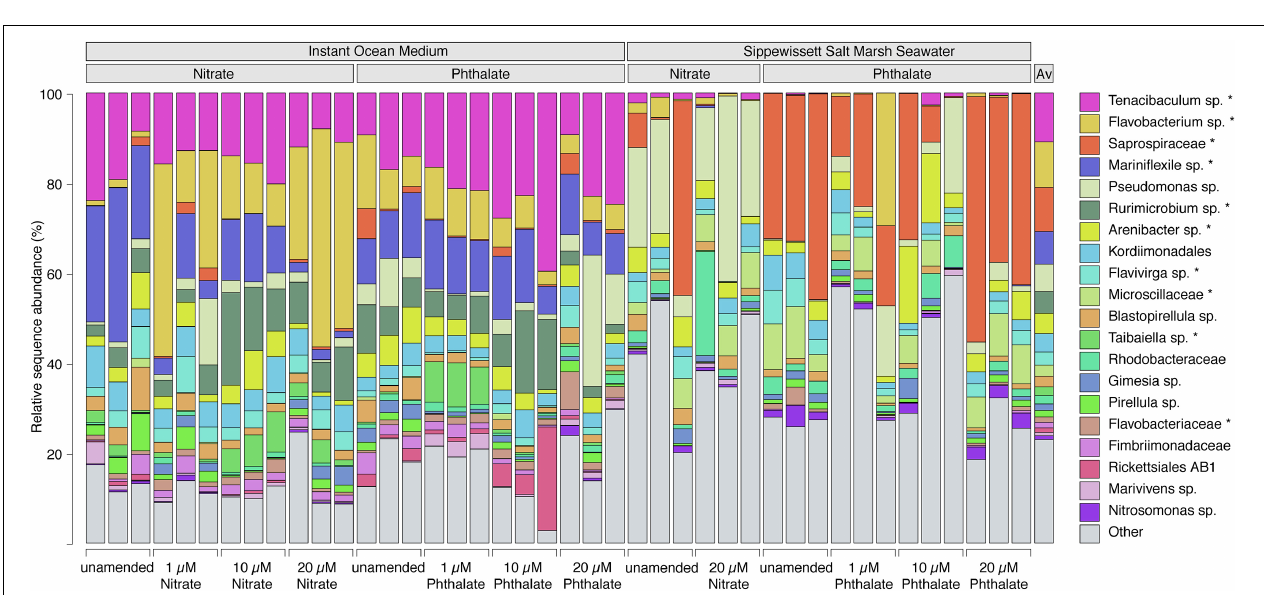
FIGURE 7 | Non-metric multidimensional scaling ordination based on a distance matrix of all available amplicon sequence variants (ASVs). The microbial communities exposed to different pollutants and concentrations are significantly different from each other. Each dot represents the total bacterial community of a sample, the closer the dots are the more similar are the underlying communities. The dots of each condition are connected to the weighted average mean of within group distances (centroid), ellipses represent one standard deviation of the centroid. Ellipses that do not overlap generally show substantial differences between groups.